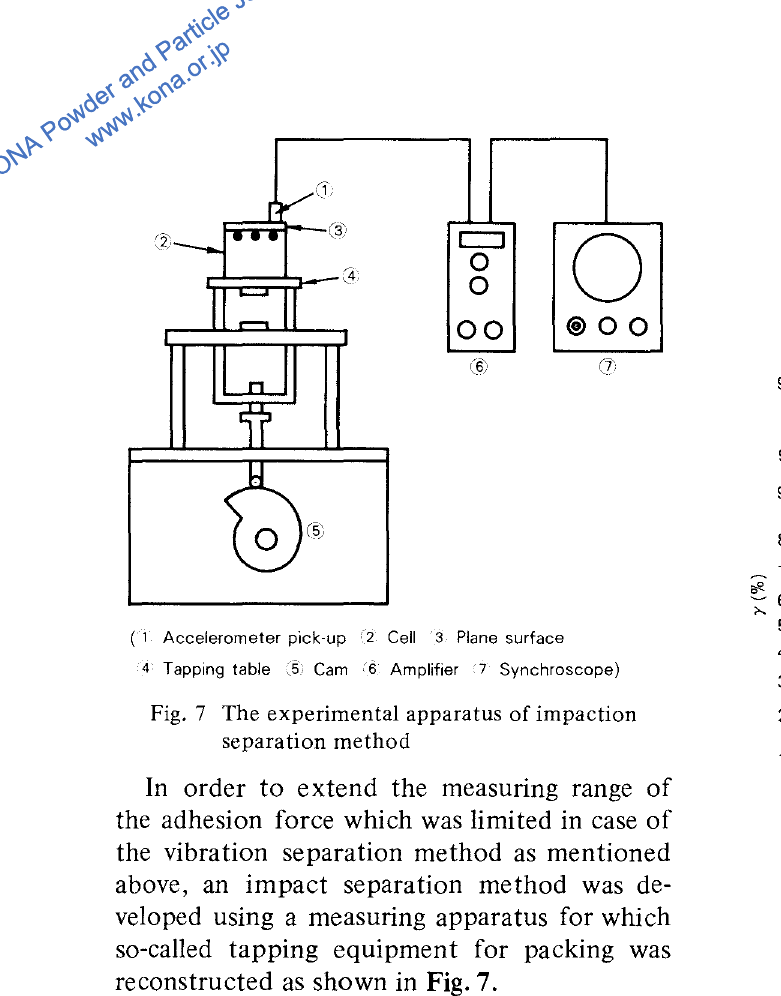
Fig. 7 The experimental apparatus of impaction separation method